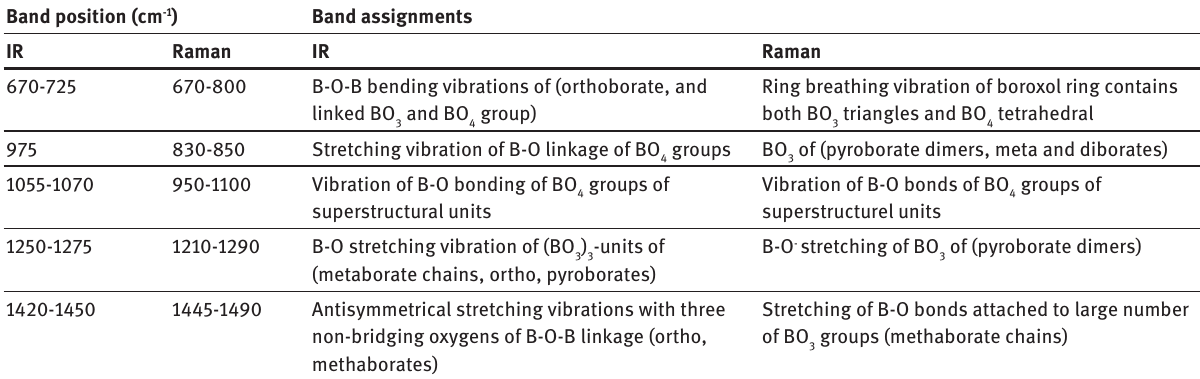
Table 2: Infrared and Raman absorption bands of borate structural units. Band position (cm -1 ) Band assignments IR